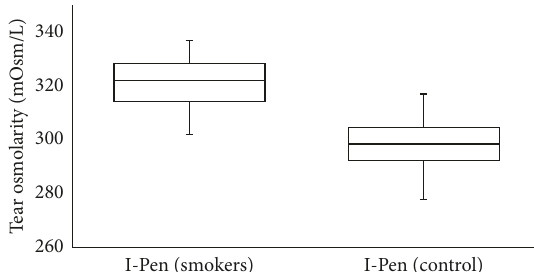
Figure 3: Side-by-side boxplot for tear osmolarity measurements using the I-Pen system in the study (smokers) and control (non- smokers)